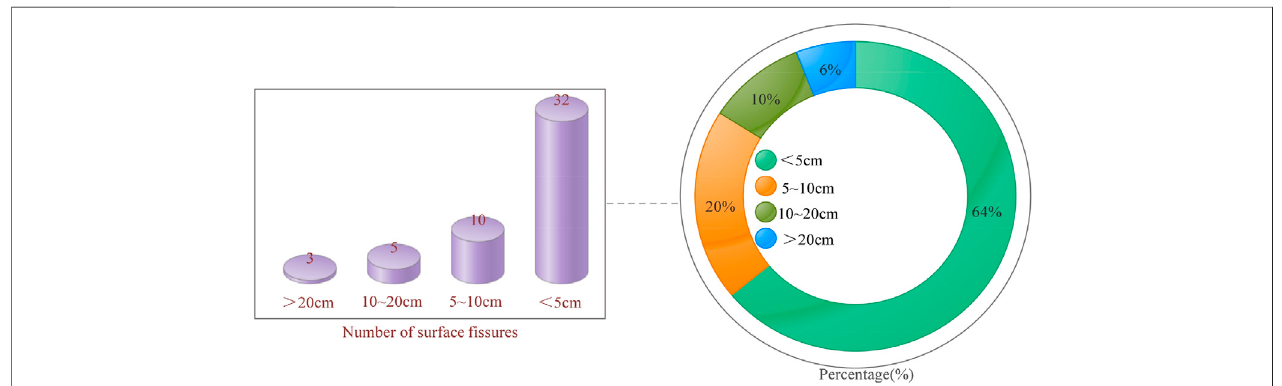
FIGURE 6 | Dynamic development characteristics of ground fi ssures in the gully.